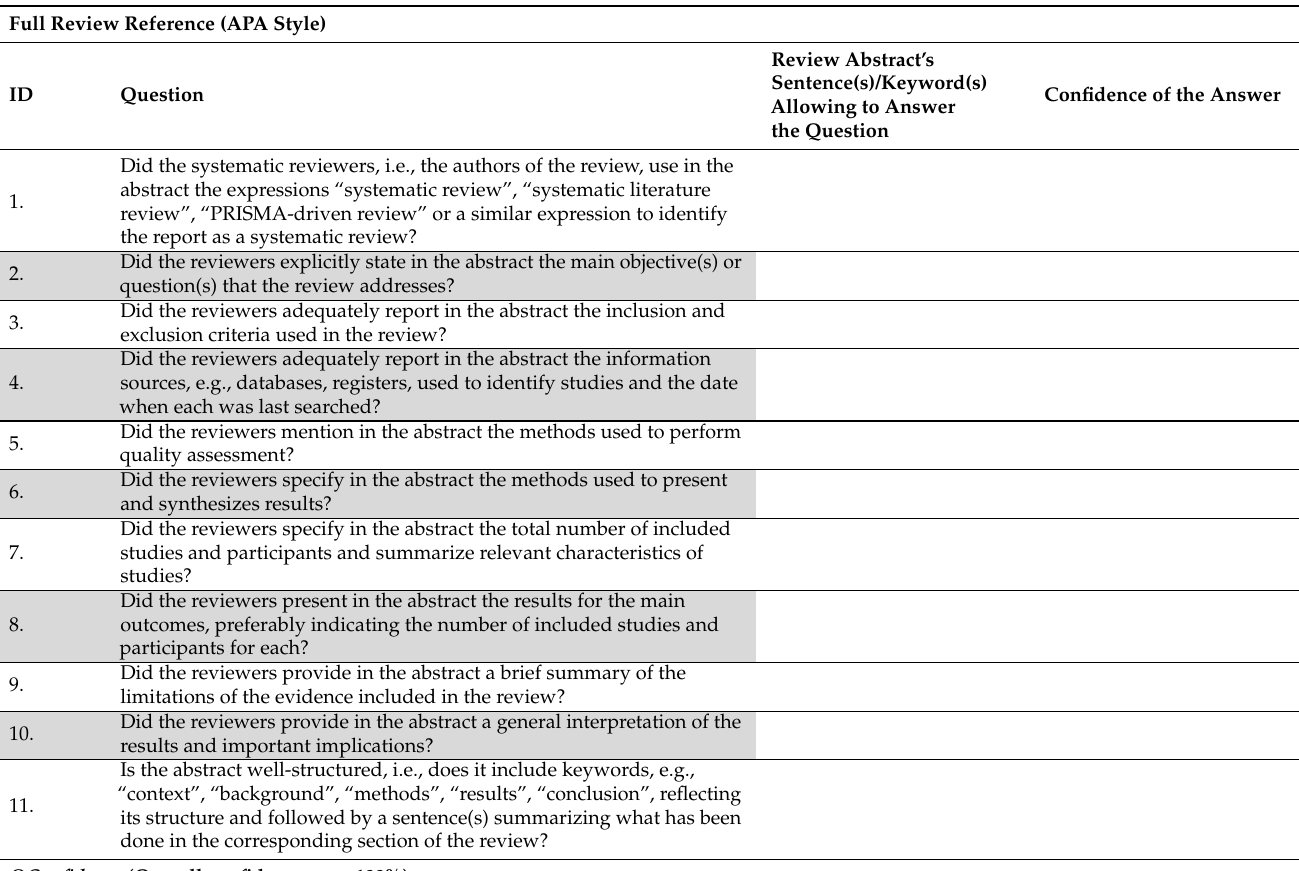
Table 1. Question-Driven Data Extraction Form to Assess the Systematicity of Review